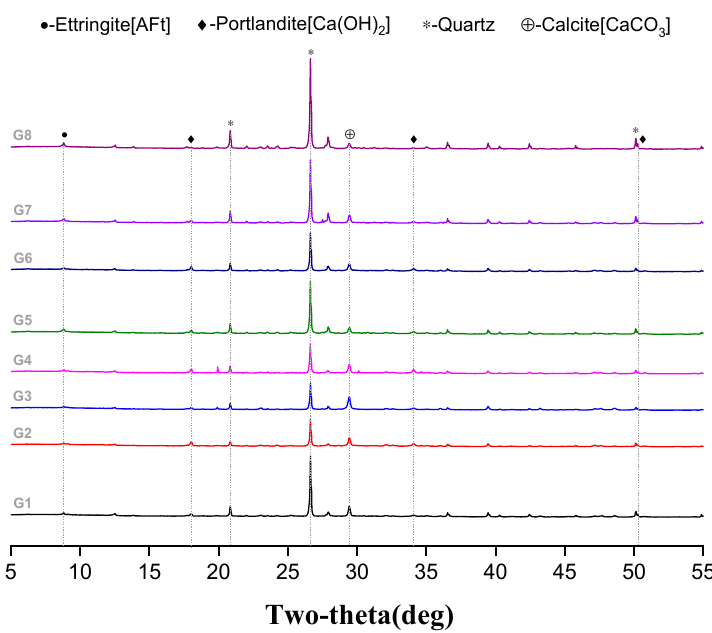
Figure 11. XRD pattern of 8 groups of concrete.